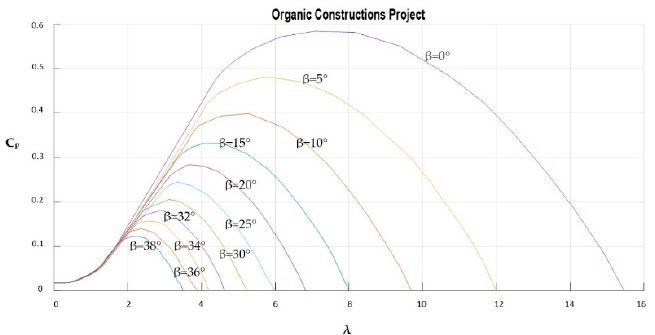
Figure 7. Cp vs. tip speed ( λ ). Curve is plotted for different β .